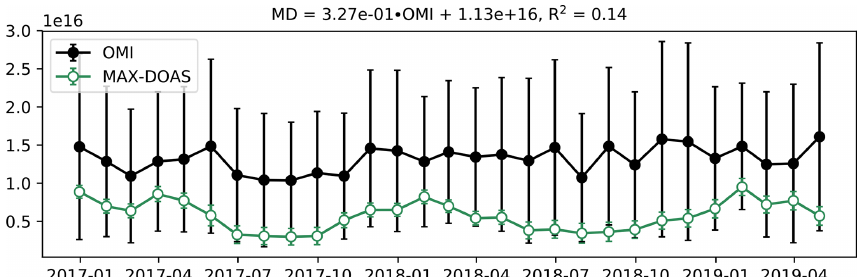
Figure A4. Time series of monthly averaged MAX-DOAS and OMI HCHO vertical columns (“ColumnAmount” field) at